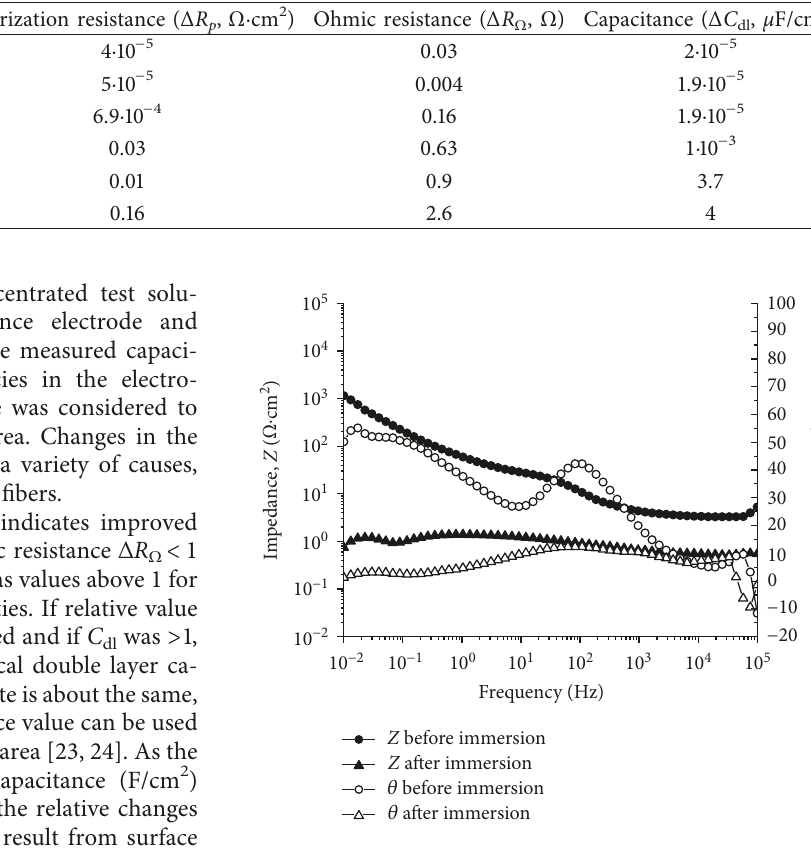
Figure 3: Impedance and phase angle before and after Watts bath immersion (fiber sample